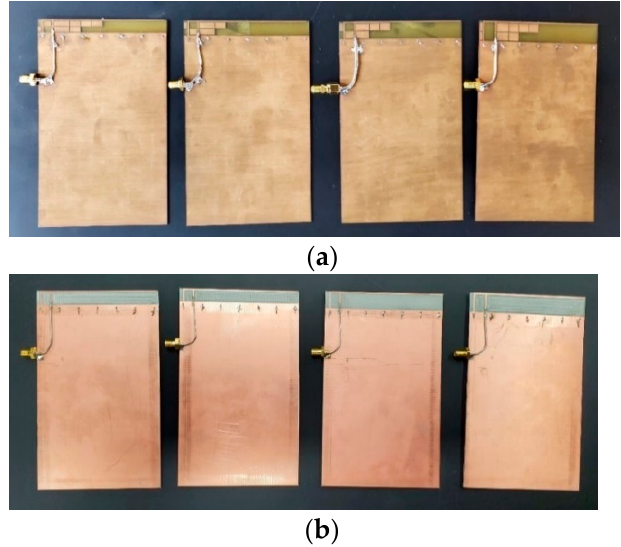
Figure 8. ( a ) The four IFA antennas with optimized parasitic patch configuration fabricated with attached connectors. ( b ) The four base IFAs measured as